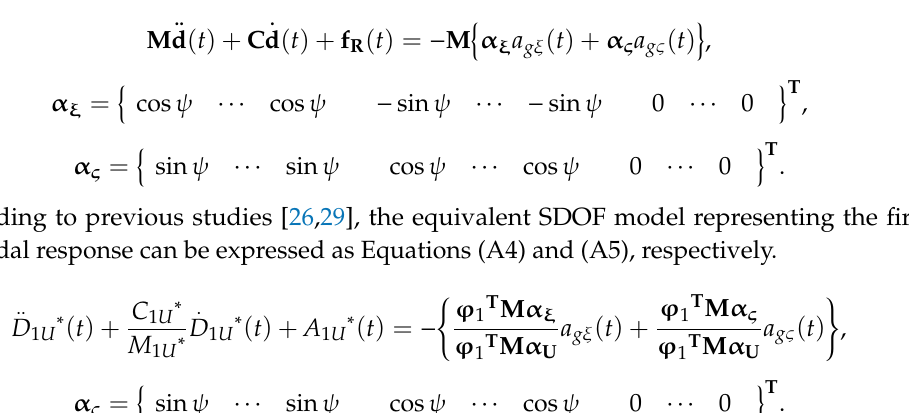
Figure A1. Equivalent SDOF model representing each mode: ( a ) first mode and ( b ) second mode.